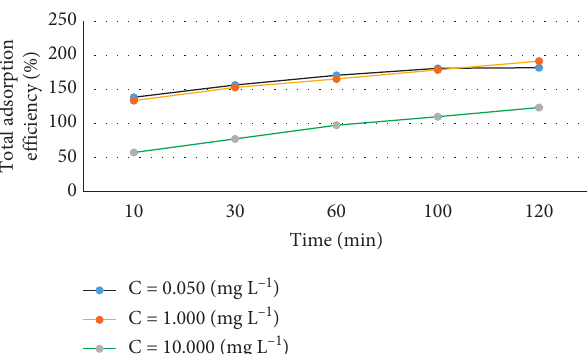
) with respect to m